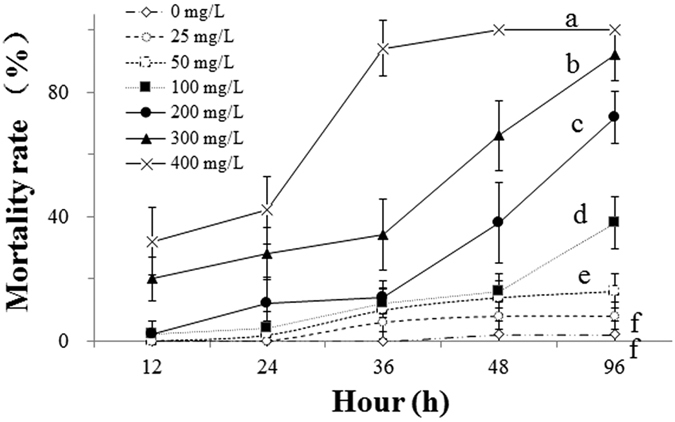
Mortality rates (means ± s.d., n = 5) of Daphnia magna individuals, at the 12th, 24th, 36th, 48th, and 96th h after exposure to seven norfloxacin concentrations (0, 25, 50, 100, 200, 300, and 400 mg L−1).Different letters indicate significant differences (P < 0.05) among norfloxacin concentrations throughout the 96-h-long experiment, according to one-way repeated measures analysis of variance (rm-ANOVA). Figure 1 was produced in Microsoft Excel 2016.